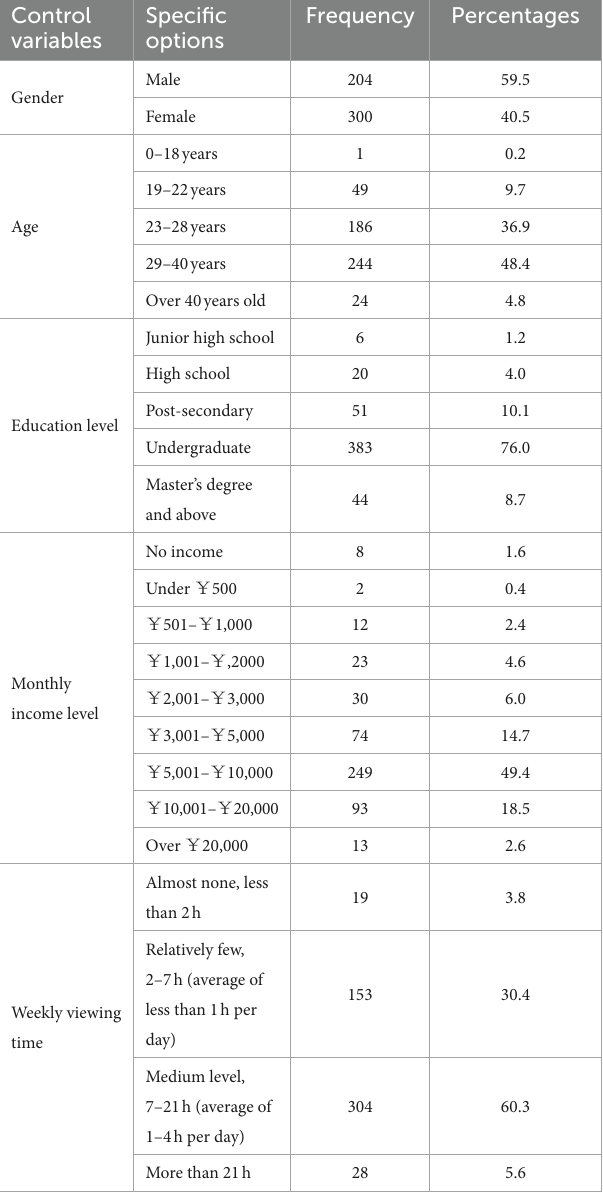
TABLE 2 Composition distribution of the sample ( N =